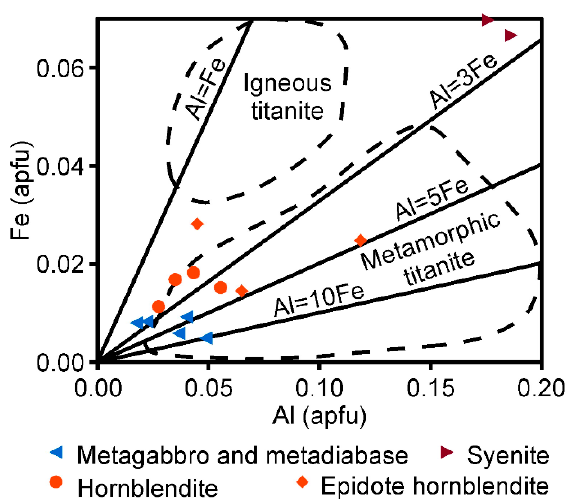
Figure 10. Titanites composition in terms of Al vs. Fe ratio. Discrimination diagram of titanites modified after Ling et al. [62], and references therein.